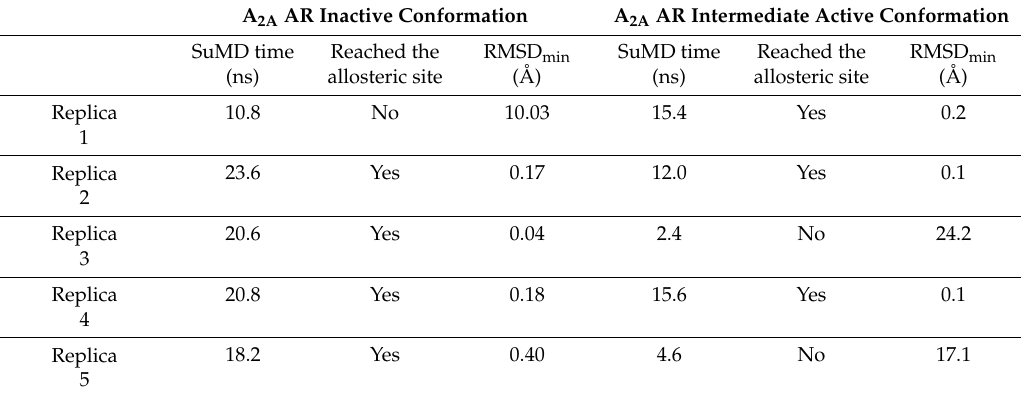
Table 2. Supervised molecular dynamics (SuMD) simulations of the sodium ion performed on the inactive (left side) and intermediate active (right side) conformations of the adenosine A 2A receptor (A 2A AR). For each replica, the SuMD simulation time, the positive or negative outcome and the minimum RMSD (RMSDmin) reached by the sodium have been reported (the crystallographic structure 4EIY was used as a